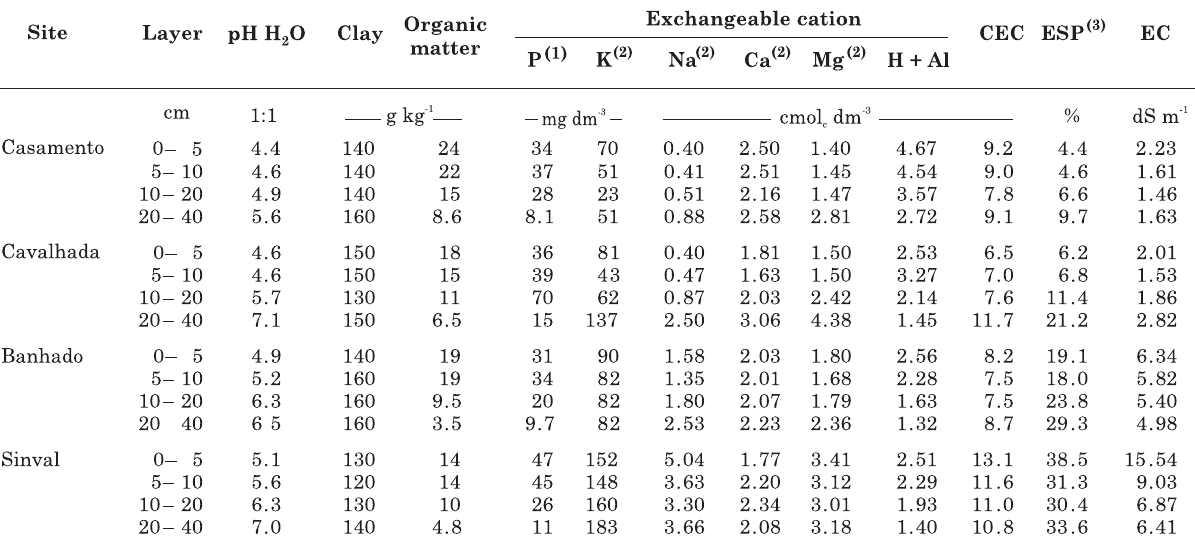
Table 1. Chemical atributes of different sites and layers of the soils used in the